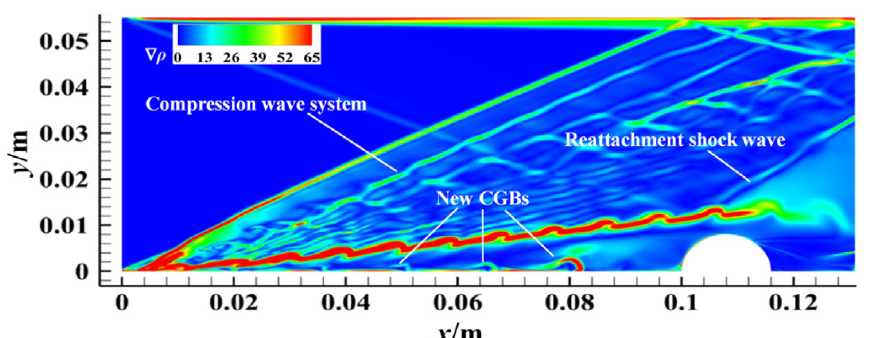
Figure 58. Flow configuration.